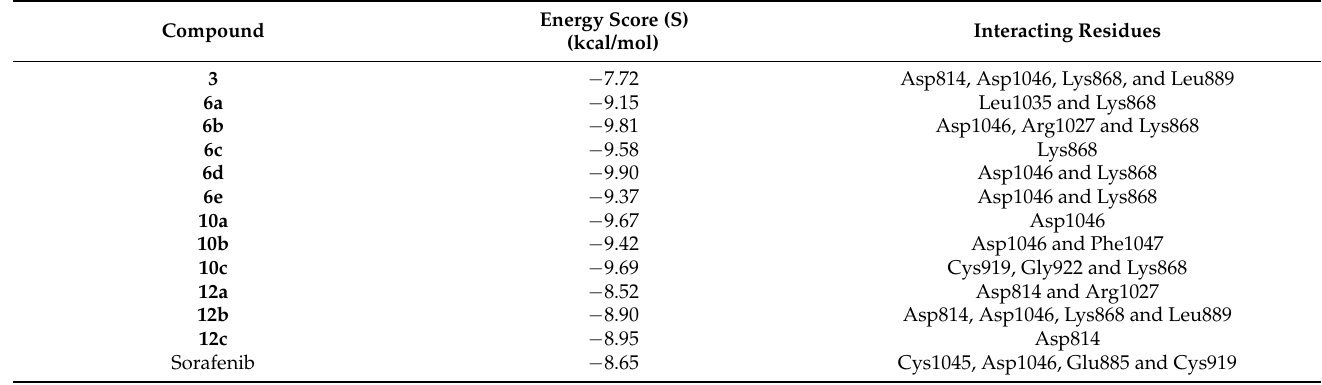
Table 1. Energy scores and receptor interactions of type II VEGFR-2 inhibitors for the